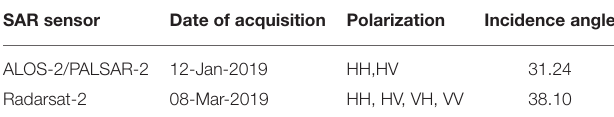
Frontiers in Forests and Global Change |